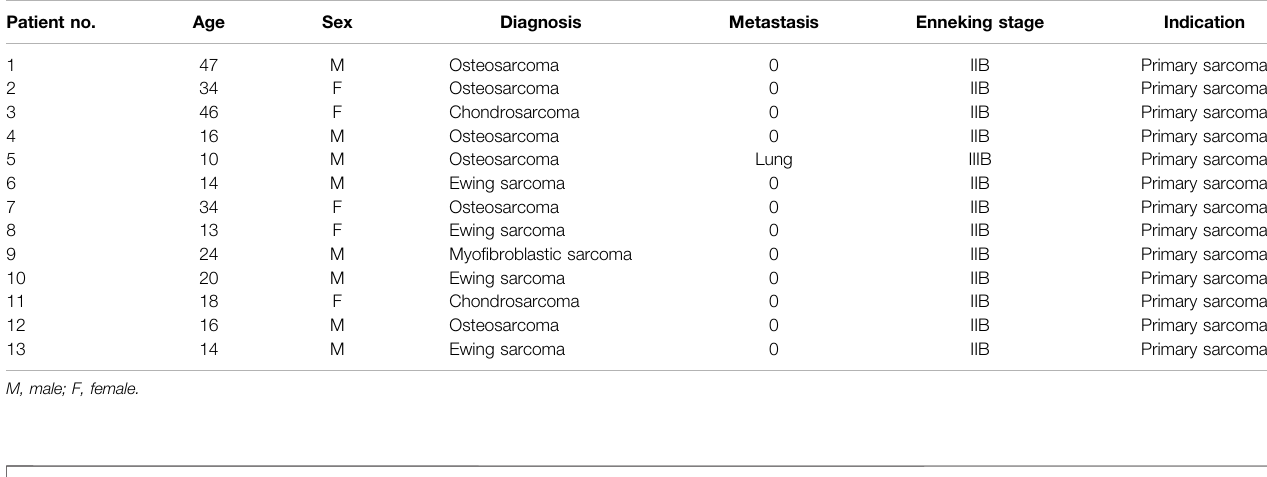
TABLE 1 | Surgical indications and stage of disease. Patient no.